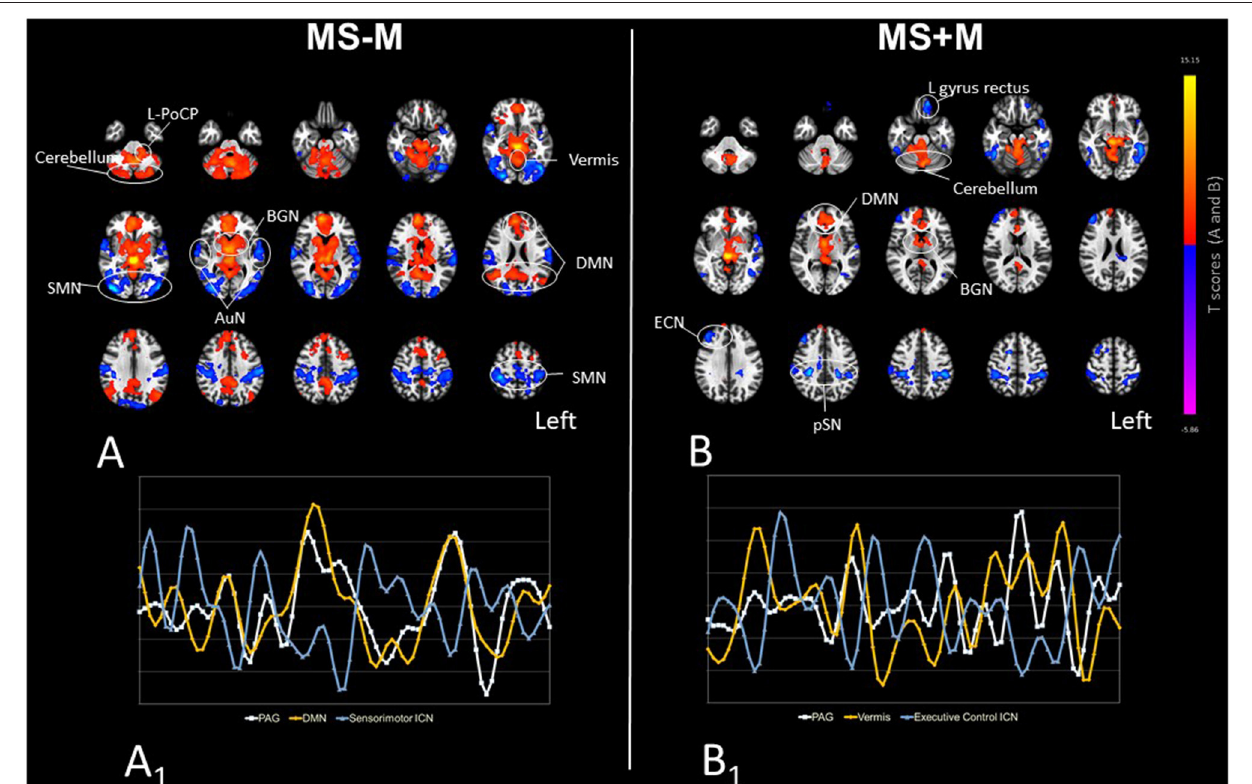
FIGURE 1 | The PAG RS-FC organization in MS-M (A) and MS + M (B) patients. Maps illustrate the areas with positive (hot colors clusters) and negative (cold colors clusters) correlation with the PAG, obtained using one-sample t -tests and set at the statistical threshold of P = 0.05 after FDR correction. The PAG-positively connected brain areas represent the “pain modulatory network” (12). Images are presented in radiological convention, overlaid on a standard ICBM-152 template for anatomical reference. Connectivity cluster labels are also provided (circles), and abbreviations are defined in the main text. (A 1 , B 1 ) illustrate exemplary time-courses of the spontaneous BOLD LFF extracted from the PAG seed, and from the areas exhibiting the strongest positive correlation (yellow) and negative correlation (blue) with the PAG, respectively in MS-M and MS + M. Negative-correlations are characterized by an out-of-phase time-course with respect to the PAG.